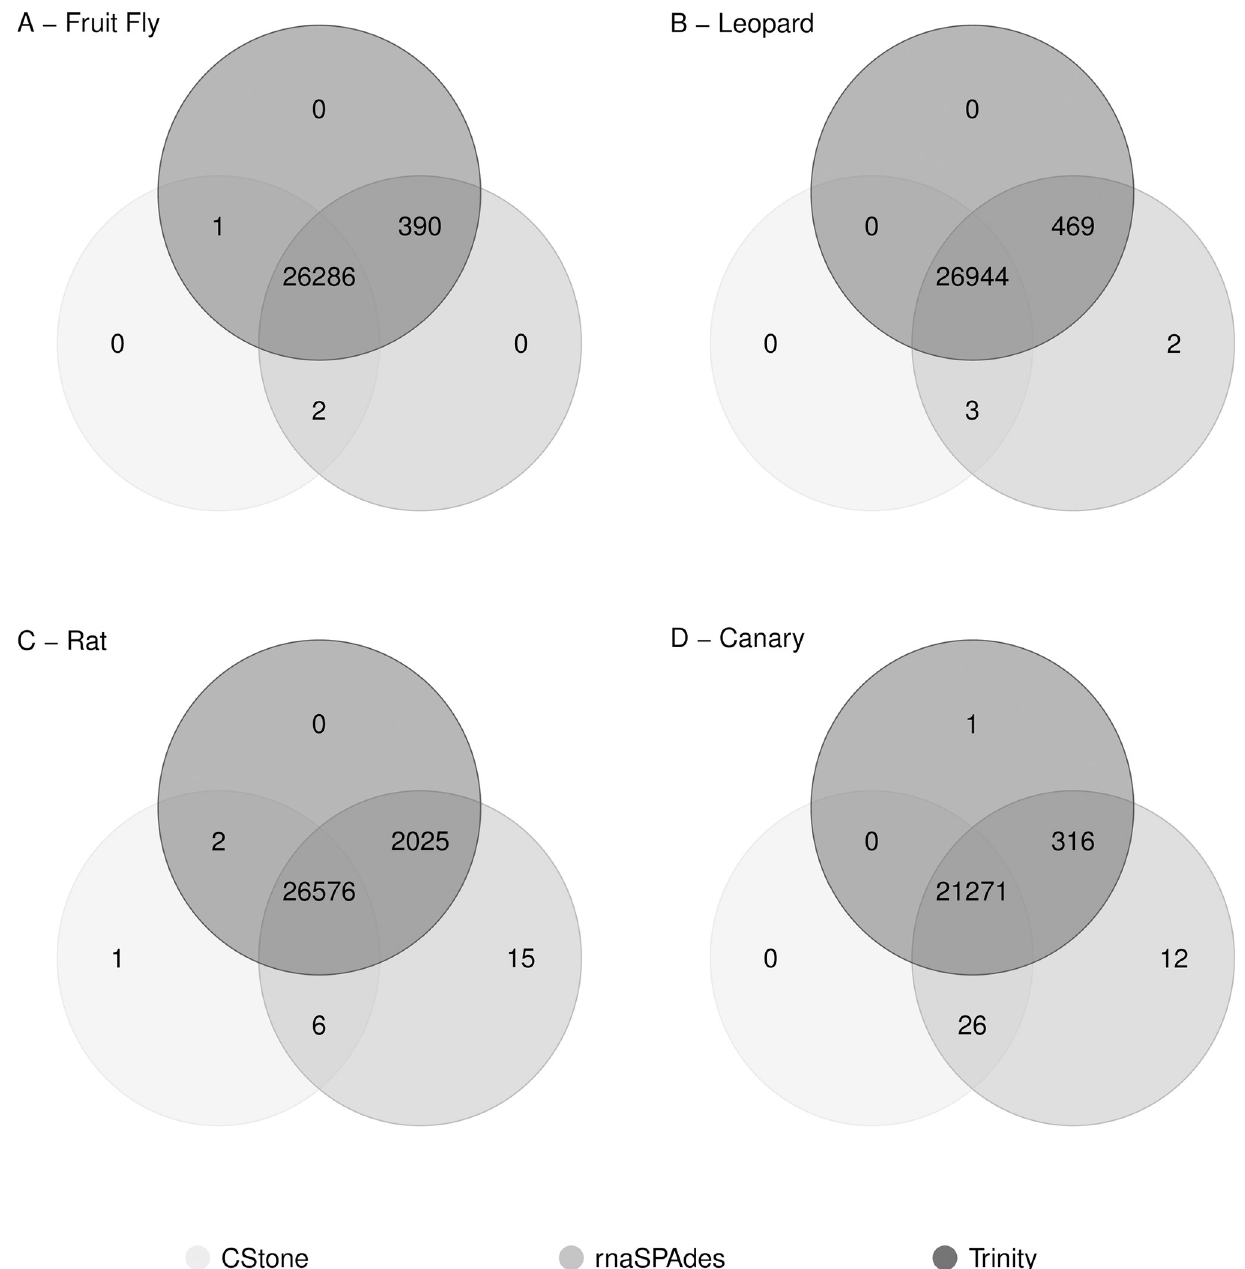
Fig 9. Agreeability between assemblers. Venn diagram showing the extent to which contigs produced by each assembler, when run on simulated data, agree in their representation of the species-specific cDNA reference transcripts. The key indicates the colour of the circle representing each assembler.